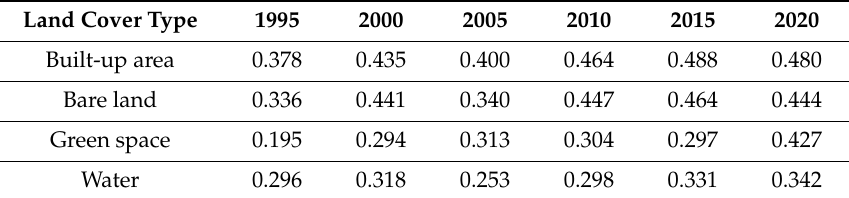
Table 5. Normalized average land surface temperatures of different land cover types in the study area across the study period.